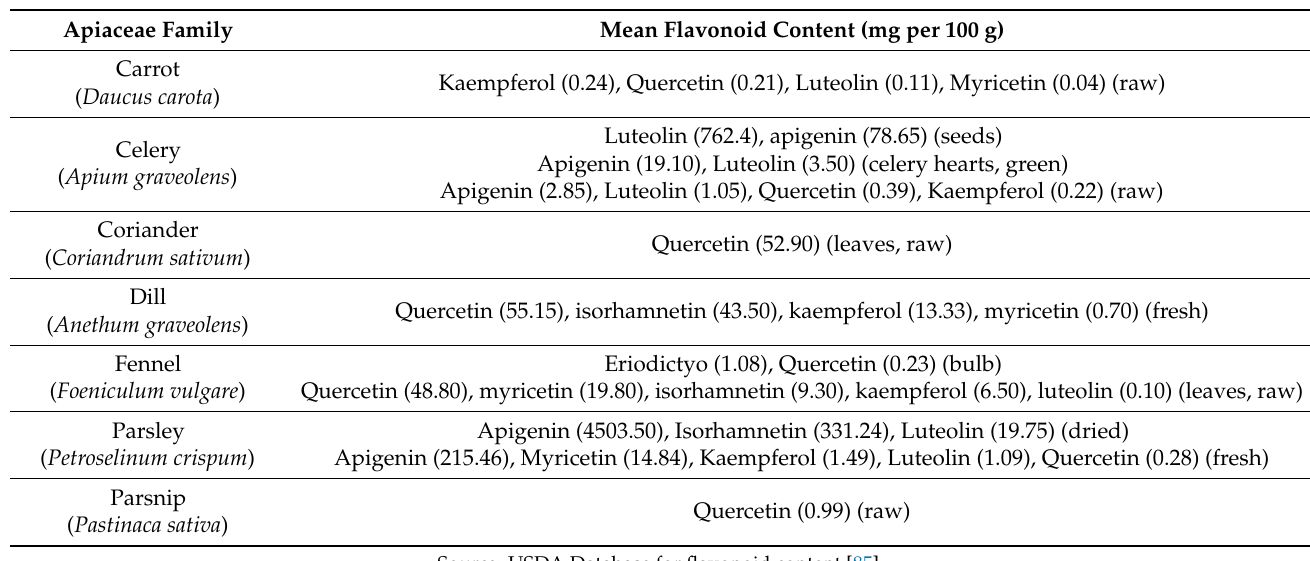
Table 3. Flavonoid content of some Apiaceae